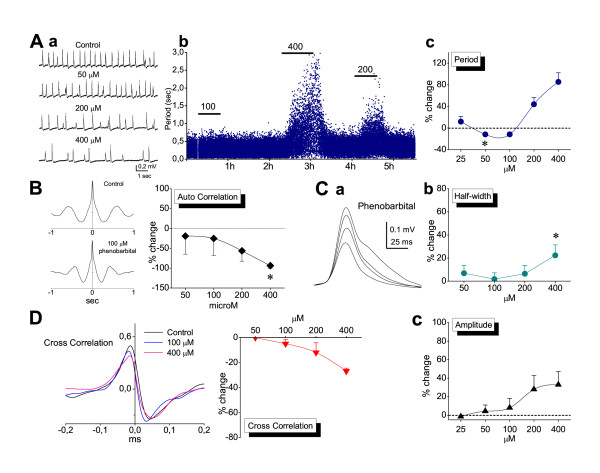
Effects of phenobarbital on SPWs. A. SPW-R complexes recorded from a slice bathed in normal medium and under consequently increasing concentrations of phenobarbital (a) showing that the rate of spontaneous activity was increased at 50 and 100 μM and reduced at 200 and 400 μM (asterisk denotes the lowest drug concentration with statistical significance effect, paired t-test, P < 0.001 paired t t-test, P < 0.05). In the plot of instantaneous period (b) note that even at the highest concentration (400 μM) phenobarbital did not abolish spontaneous activity. Measures for constructing the plot of collective data (c) were obtained from 3, 6, 10, 12 and 18 slices respectively for the five drug concentrations. B. Example of auto-correlation analysis for SPWs recorded in one slice before and during application of 100 μM of phenobarbital (diagram on the left). The collective data plot (diagram on the right) illustrates that only at 400 μM did the drug significantly reduce rhythmicity of SPWs (asterisk, P < 0.05). Data were obtained from 6, 10, 10 and 12 slices respectively for the four drug concentrations. C. Averages of filtered SPWs recorded from an epoch lasting two minutes (a) obtained from a slice bathed in normal medium (trace with the smallest amplitude) and increasing concentrations of phenobarbital (50, 200 and 400 μM, traces with consecutively increasing amplitude). Note the concomitant increase in the falling phase and the amplitude of the potentials. The drug significantly increased half-width of SPWs at the highest concentration of 400 μM (b). However, the drug did not significantly change the amplitude of SPWs at any concentration (c). Data in collective plots were obtained from 6, 10, 12 and 18 slices respectively for the four drug concentrations in half-width and from 3, 6, 10, 12 and 18 slices for the five concentrations in amplitude. D. Phenobarbital significantly decreased synchronization only at 400 μM, as illustrated in the example (on the left) and collective diagram (on the right, paired t-test, P < 0.05). The concentration of 25 μM is missing from the plots of auto-correlation, half-width and cross-correlation because measures of these variables were obtained from only one experiment.